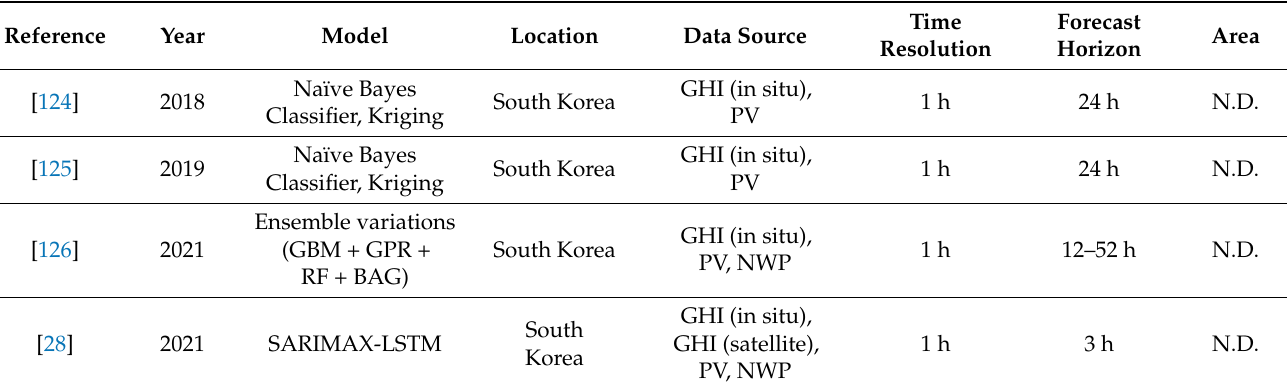
Table 6. Summary of available literature (2018–2021) for the application of hybrid methods regarding spatio-temporal solar forecasting applications.